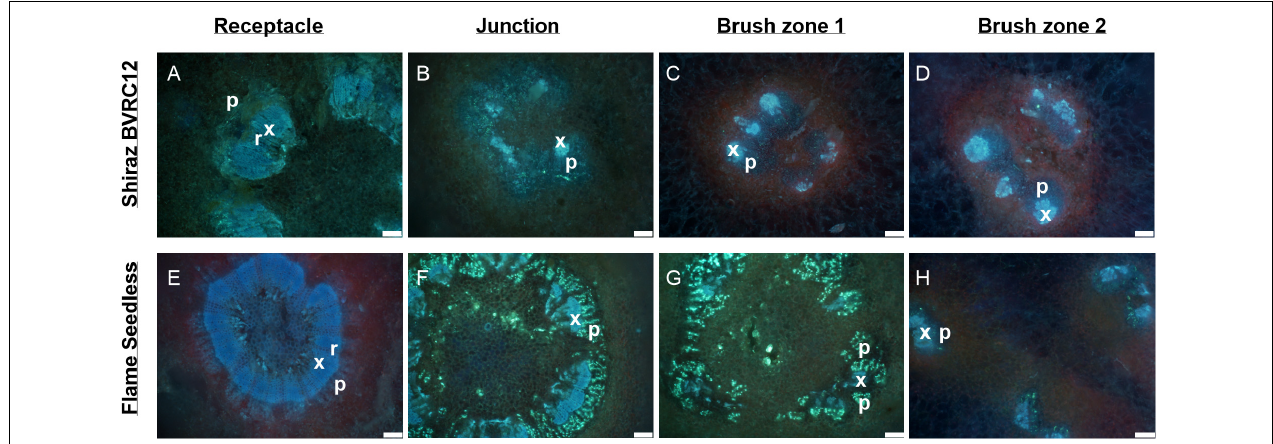
FIGURE 5 | Autofluorescence of vascular bundles in the brush zone of post-veraison (85 DAA, season 2017/2018) Shiraz BVRC (A,B) , Sauvignon Blanc (C,D) , and Flame Seedless (methanol-fixed) with two filters combinations applied: (1) excitation filter 330–385 nm, dichroic mirror 400 nm and barrier filter 420 nm, showing intense blue fluorescence of xylem (A–C) and intense blue in the cell lumens surrounding the vascular bundles (A) ; (2) excitation filter 520–550 nm, dichroic mirror 565 nm and barrier filter 580 nm, showing strong green fluorescence of extractives in the cell lumens sounding the vascular bundles (B,D,F) . Scale bar = 100 µ m.